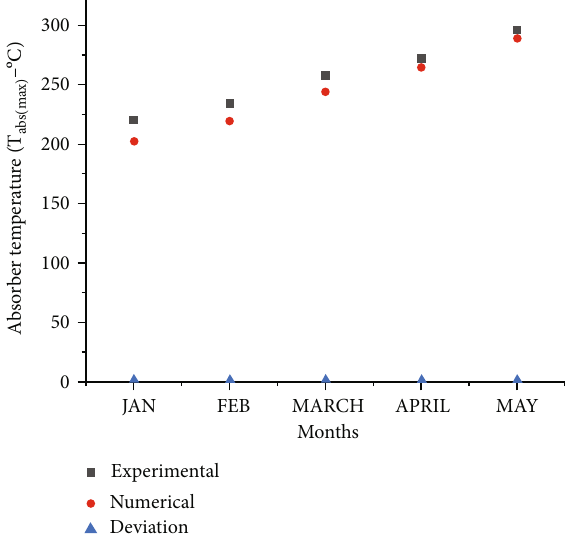
Figure 21: Deviation between experimental and numerical values of working fl uid outlet temperature during January to May.